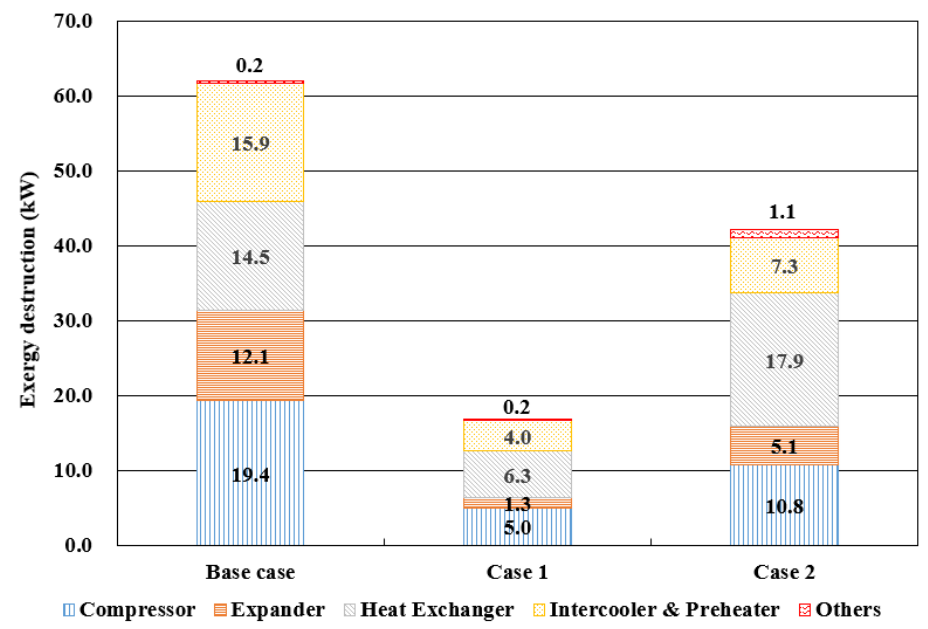
Figure 15. Exergy destruction of components in the optimized systems.